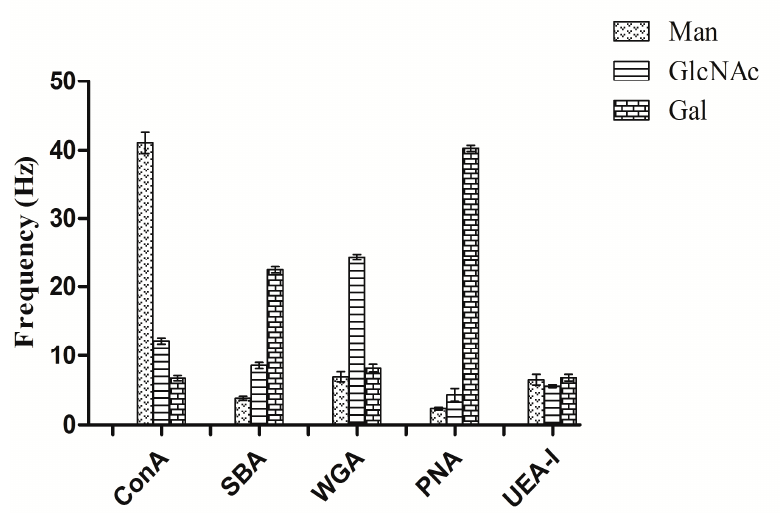
Figure 5. Five different lectin binding to GlcNAc-functionalized sensor chip surface. The data were collected after 400 s.